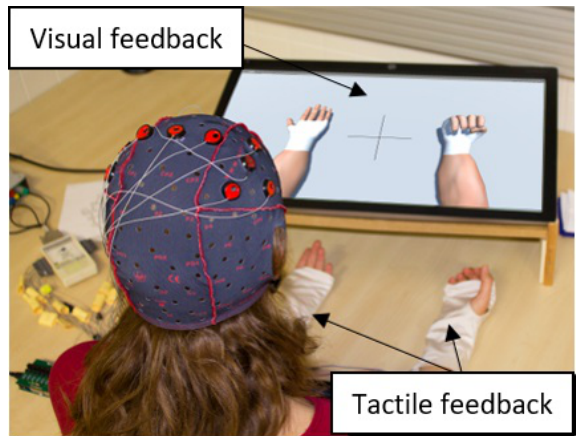
Figure 2. Modalities of feedback provided during the sessions, i.e., multimodal feedback composed of vibrotactile and realistic visual stimuli or unimodal feedback composed of realistic visual stimuli